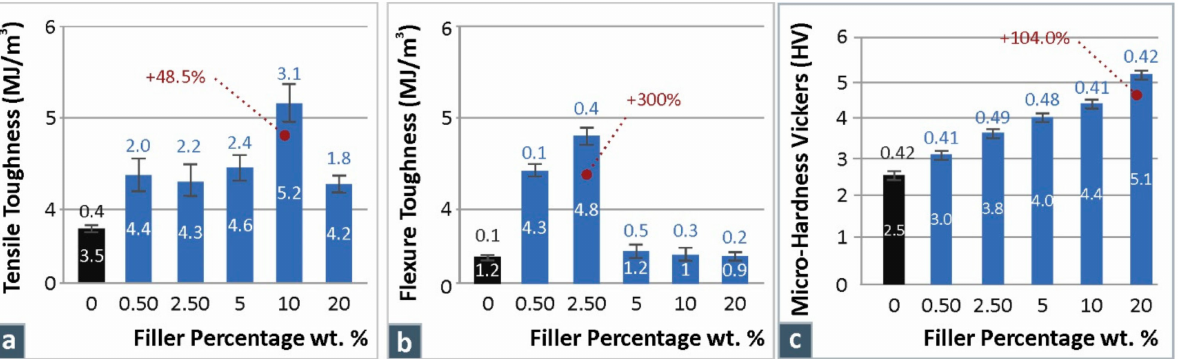
Figure 4. Overall ( a ) tensile toughness of HDPE with TiO 2 filler at 0, 0, 5, 10, and 20 wt.%; and ( b ) flex- ure toughness of HDPE with TiO 2 filler at 0, 0, 5, 10, and 20 wt.% ( c ) the overall micro-hardness Vickers results for HDPE unfilled and HDPE with TiO 2